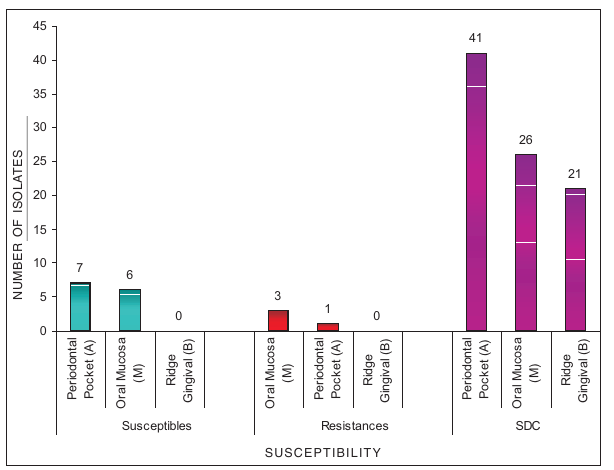
Fig. 3b - Susceptibility of Candida non albicans isolates to Itraconazole for sites